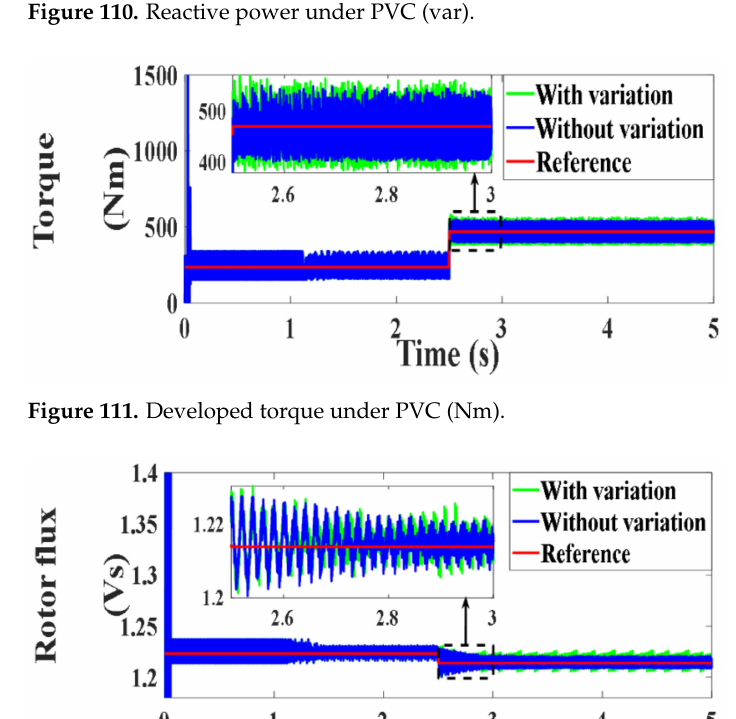
Figure 110. Reactive power under PVC (var).